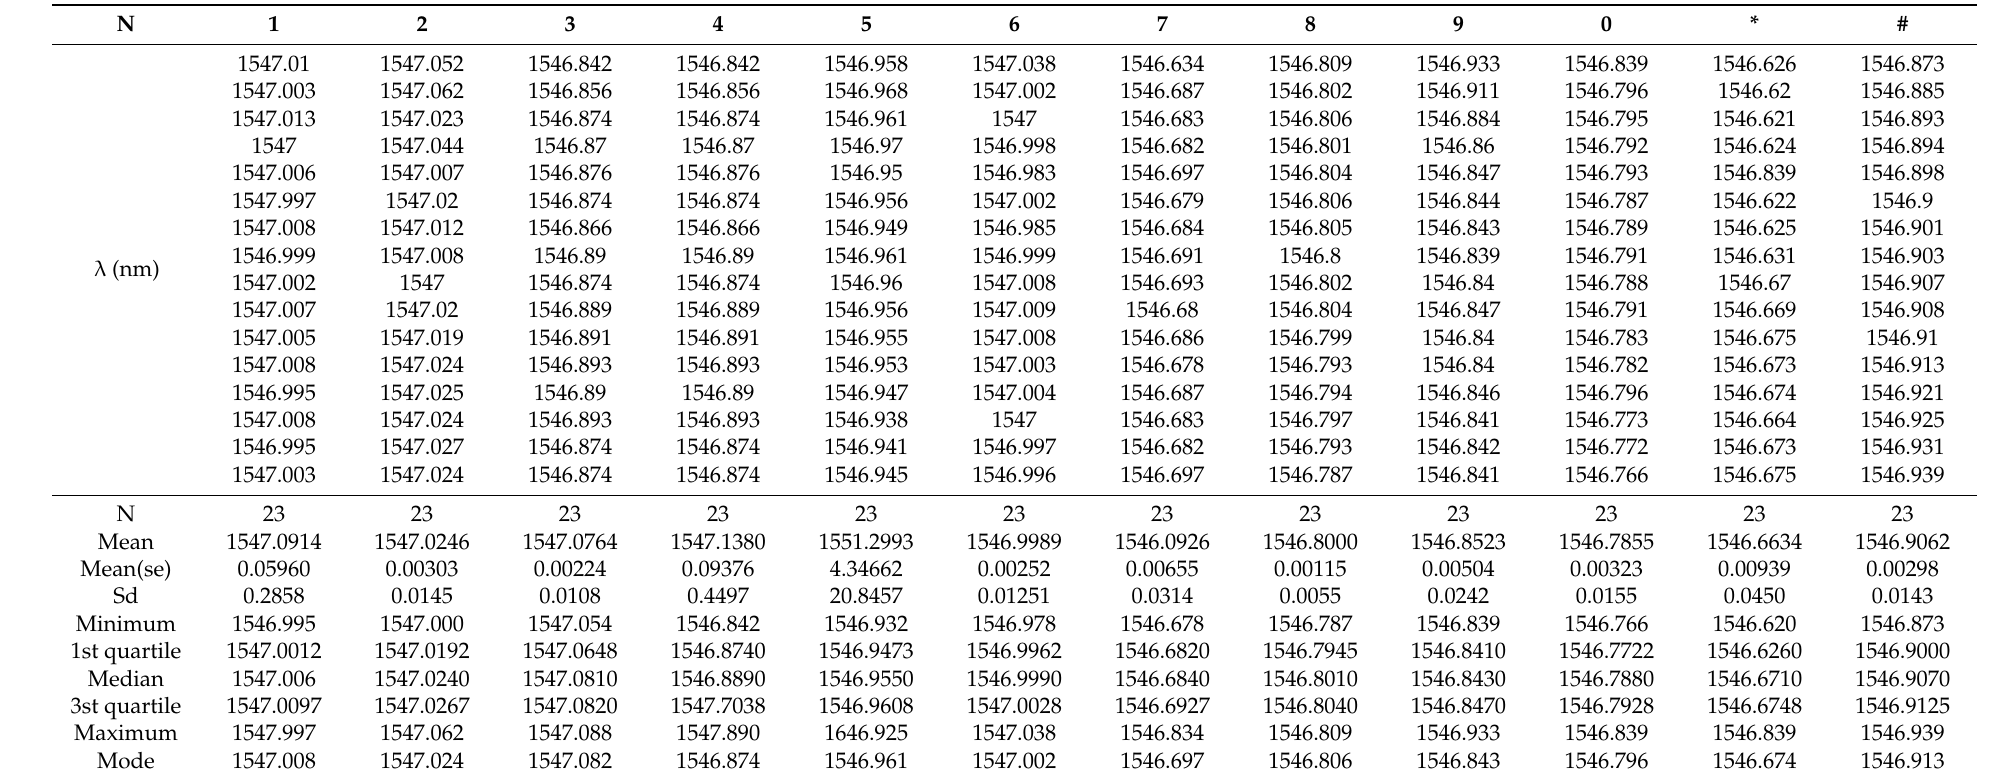
Table A2. Wavelength of Subject Phone Number